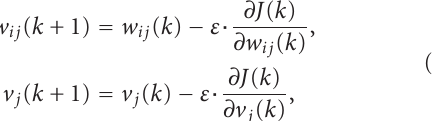
Figure 1: Feedforward neural